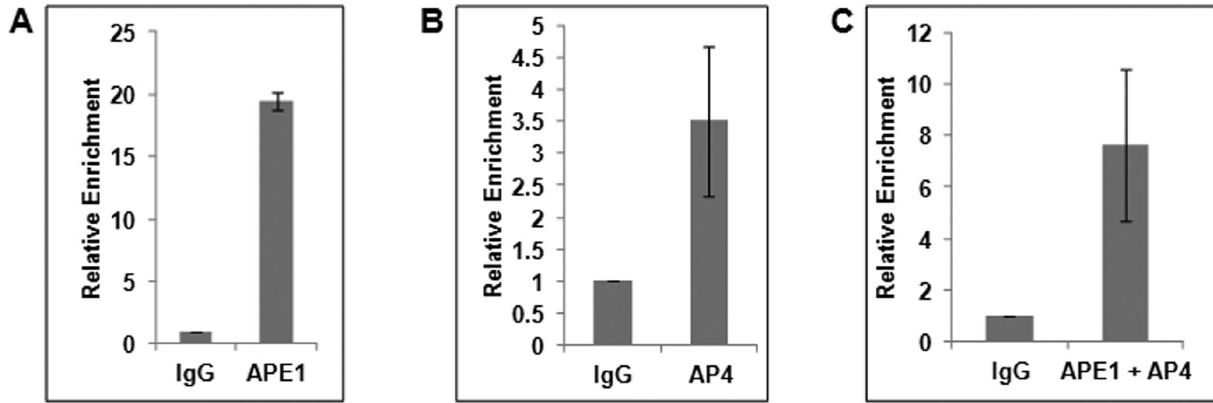
Figure 4. Association of APE1 and AP4 in p21 proximal promoter region. ( A & B ) ChIP Real Time PCR analysis showing relative enrichment of ( A ) APE1 and ( B ) AP4 in p21 proximal promoter containing AP4-responsive E-Box elements in HCT116 p53null cells. ( C ) Re-ChIP (first IP with a -APE1 and the second IP with a -AP4 antibody) analysis showing simultaneous recruitment of APE1 and AP4 in this promoter region.